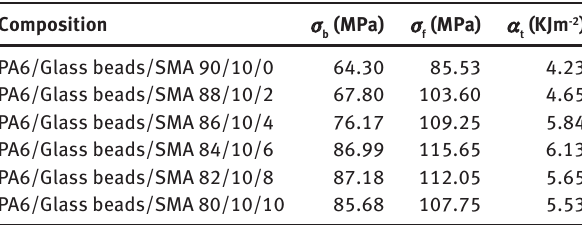
Table 2 Effect of SMA content on mechanical properties of LPA6/ Glass beads/SMA composites.